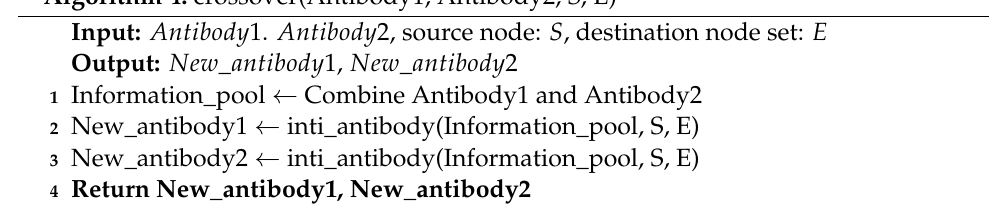
Algorithm 4: crossover(Antibody1, Antibody2, S, E)